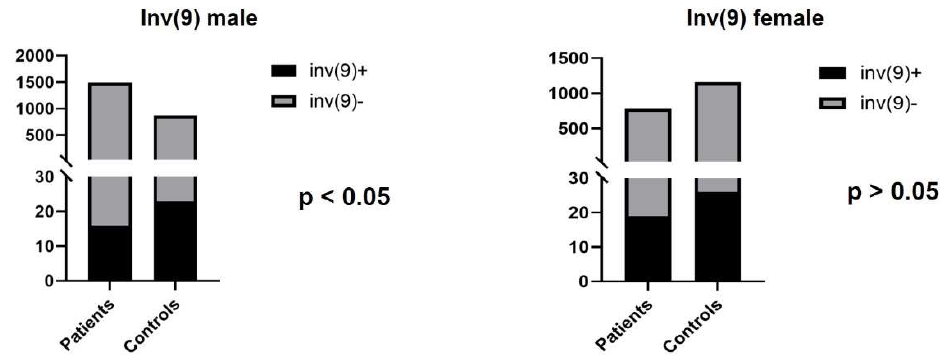
Figure 4. The number of infertile patients and control individuals with inv(9).